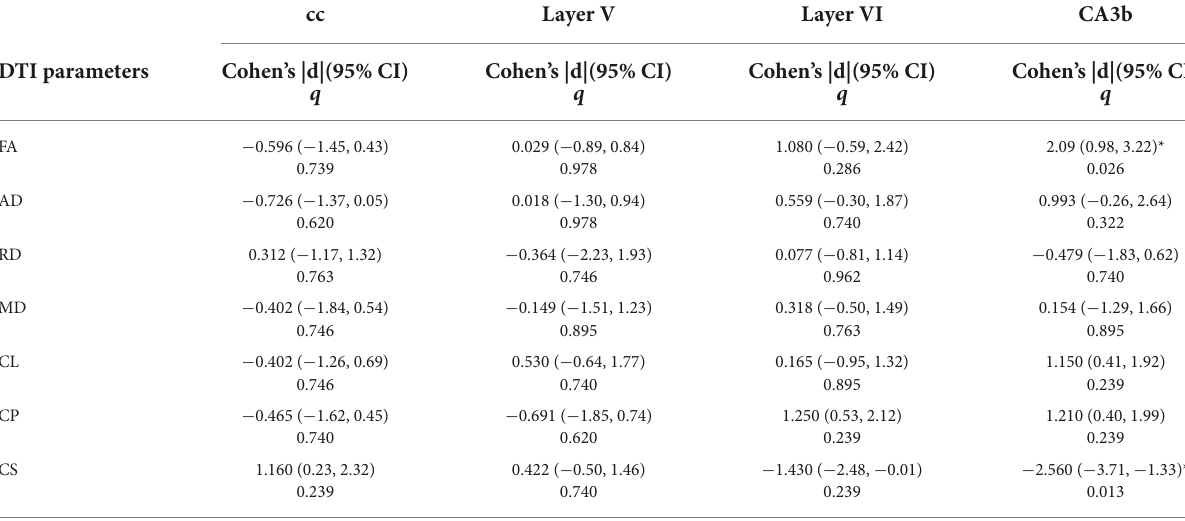
TABLE 1 Effect of SE-induced brain damage in quantitative ROI-based analyses of DTI